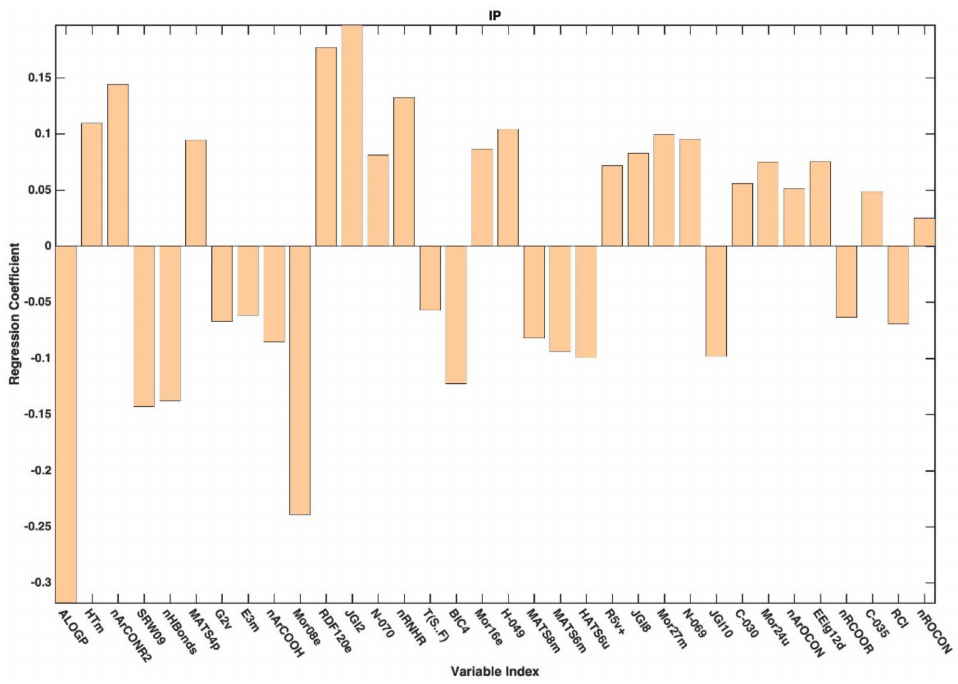
Figure A5. Regression coefficients associated to the descriptors selected by CovSel for the PLS-DA model based on the IP-based dataset. Table A1. Comprehensive list of the descriptors selected in the final